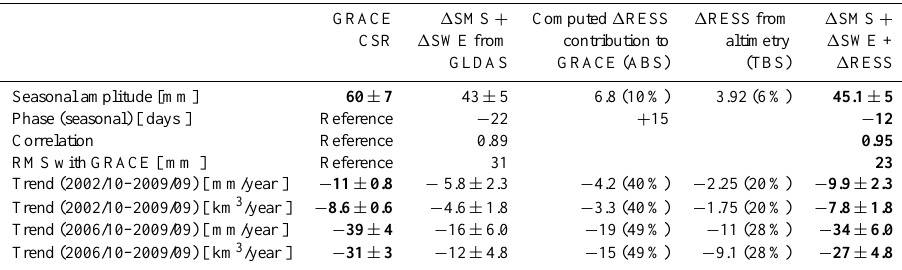
Table 2. Comparison between GRACE changes in soil moisture ( 1 SMS) and snow water equivalent ( 1 SWES) from GLDAS (mean of CLM, MOSAIC, NOAH, VIC models) and reservoir storage changes ( 1 RESS) for Tigris–Euphrates basin. Please refer to supplementary material Table S1 for comparison with more LSM models. Uncertainty is given as the impact of variability of 1 SMS + 1 SWES among LSMs in GLDAS. Uncertainty of 1 RESS is not taken into account GRACE 1 SMS + Computed 1 RESS 1 RESS from 1 SMS + CSR 1 SWE